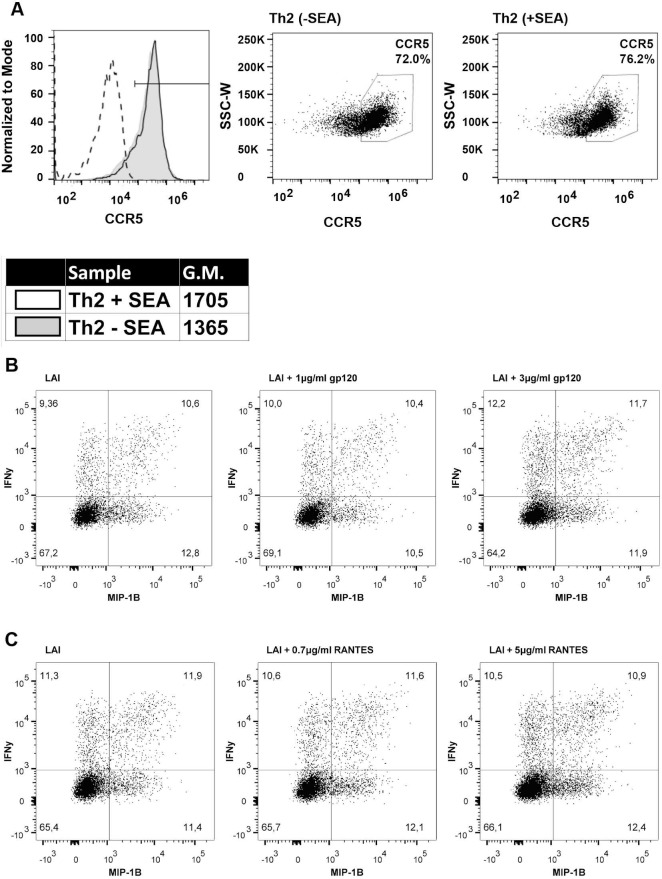
CCR5 expression does not correlate with altered SF162 infection.(A) Th2 cell cultures induced by DCs matured in absence or presence of SEA (dotted line unstained control), analyzed for the percentage of cells with high levels of CCR5 on their surface as well as the quantity of CCR5 on the surface of each cell (geometric mean). (B) Dot-plots showing the percentage of IFN-γ (y-axis) and MIP-1β (x-axis) producing T-cells in the LAI+ fraction of LAI infected cultures (left), LAI infected cultures with 1μg/ml (middle) or 3μg/ml (right) monomeric SF162 gp120 added 24h after LAI infection. (C) Dotplots showing percentage of IFN-γ (y-axis) and MIP-1β (x-axis) producing T-cells in the LAI+ fraction of LAI infected cultures (left), LAI infected cultures with 0.7μg/ml (middle) or 5μg/ml (right) RANTES added 24h after LAI infection. (A-C) Are representative figures of experiments performed at least 3 times.